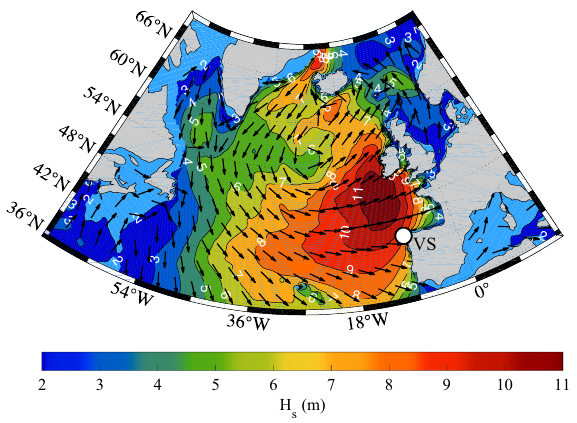
Figure 2. Wave conditions. Significant wave height (m) and mean wave direction (arrows, decimated for graphical purposes) on January 06, 2014, at 12 UTC. Note the large area of high energy propagating from the Atlantic Ocean towards the Iberian peninsula (the white dots shows the location of the Villano-Sisargas buoy, VS).